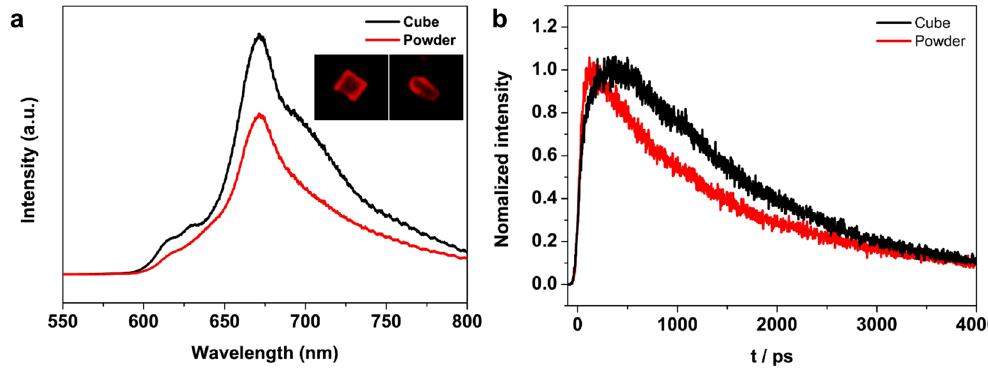
Figure 5. Photoluminescence properties of ZnTPyP powder and crystals. ( a ) Photoluminescence spectra of powder (red) and cube (black) crystal, respectively (in the inset, photoluminescence images of individual powder (left) and cube (right) crystal) ( λ laser = 338 nm and light source is a mercury lamp). ( b ) Time-resolved photoluminescence measurement of powder (red) and cube (black) crystal (detection λ laser = 667